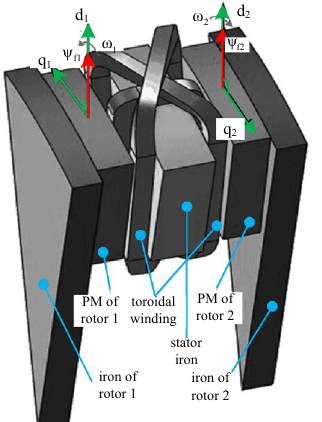
Figure 9 3-D winding structure of a CRPMSM